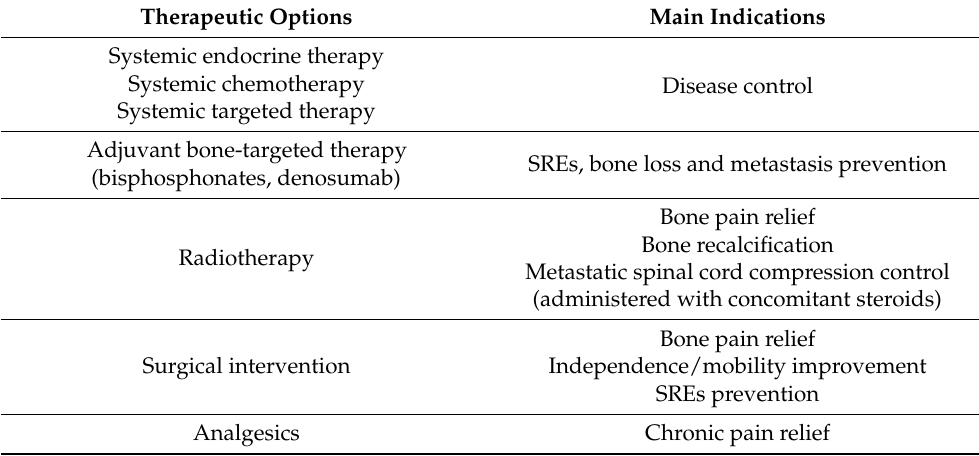
Table 1. Conventional treatments for BC bone metastasis [55].